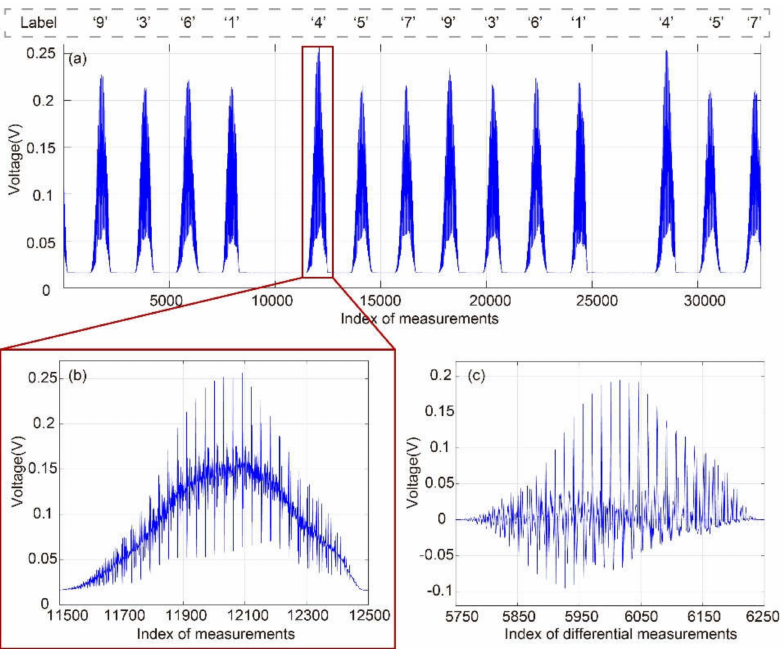
Figure 14. Single-pixel measurements of moving digits: ( a ) single-pixel measurements of objects passing through the field of view successively in 1.5 s, ( b ) partially enlarged view of ( a ) (see Visual- ization S2), and ( c ) differential measurement from ( b